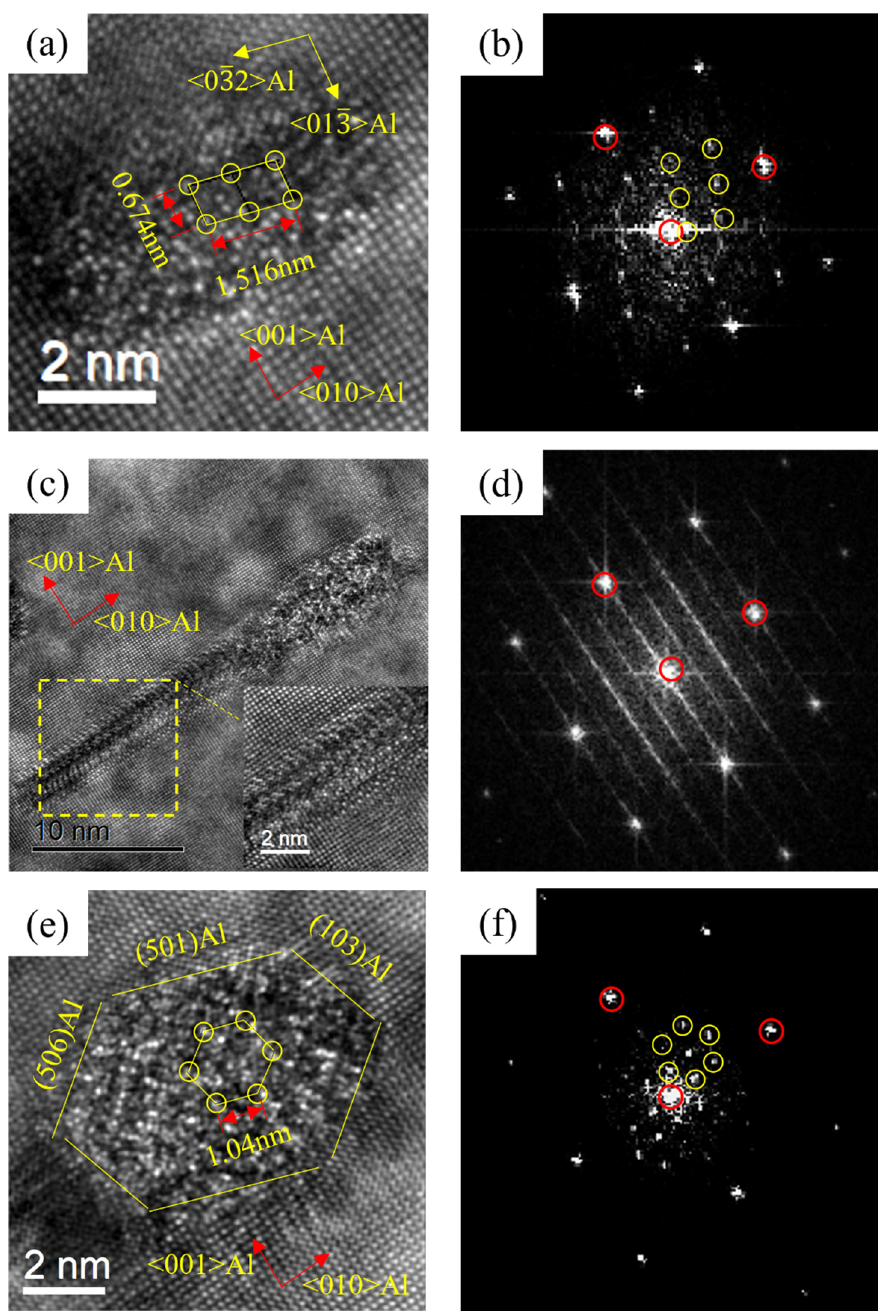
Figure 15. HRTEM and FFT pa tt erns of 0.37Cu alloy after over-aging at 175 °C for 72 h. ( a , b ) β″ ; ( c , d ) L; ( e , f ) Q ′ . ( c , d ) L; ( e , f ) Q (cid:48)